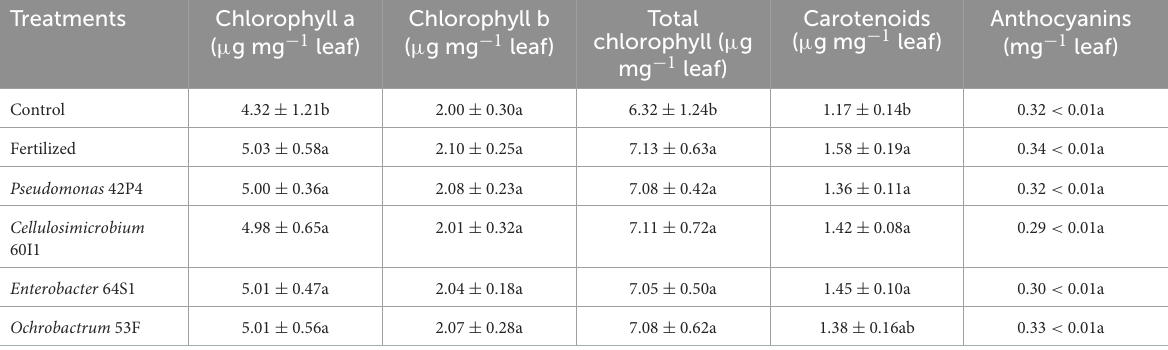
TABLE 1 Biochemical parameters determined in 90 days-old pepper plants. Treatments